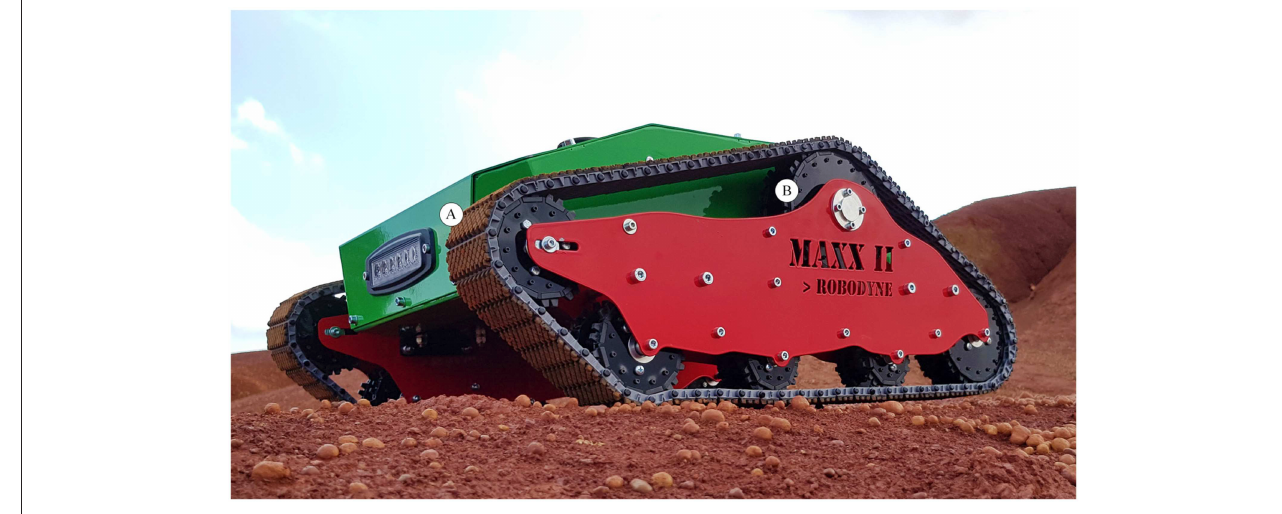
FIGURE 1 | A first version of the vehicle “maXXII” used for this research work.